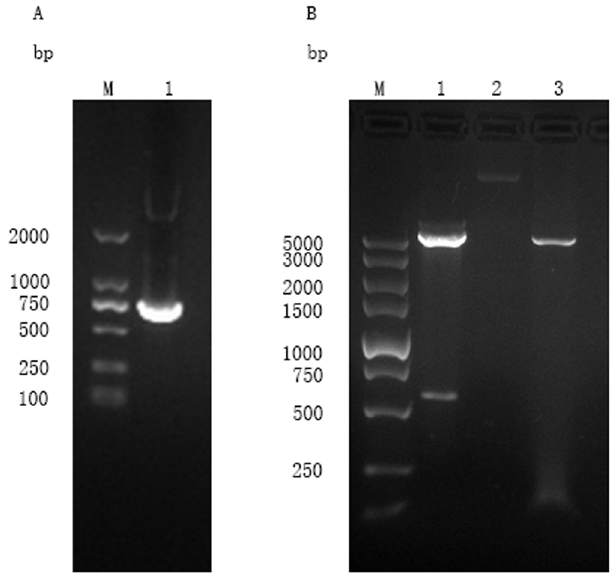
Figure 3. Agarose gel electrophoresis of UBE2F ORF and identi- fi cation of recombinant plasmid pET-32a-UBE2F digested by E coR I and Xho I. (A) (Lane M) DNA molecular weight marker DL 2000 (ordinate values in bp); (Lane 1) the ORF of UBE2F. (B) (Lane M) DNA molecular weight marker DL 5000 (ordinate values in bp); (Lane 1) the recombinant plasmid pET-32a-UBE2F digested by E coR I and Xho I; (Lane 2) the recombinant plasmid pET-32a- UBE2F; (Lane 3) the plasmid of pET-32a (+) vector digested by E coR I and Xho I.